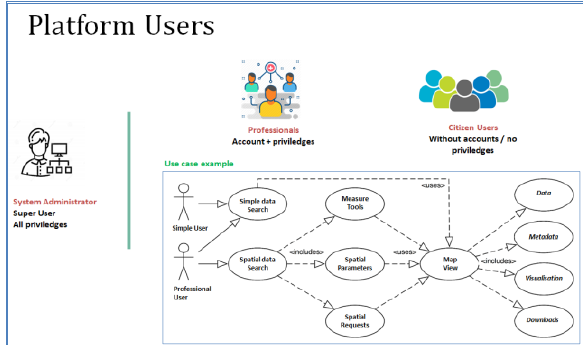
Figure 5 . Example of a use case diagram of the web